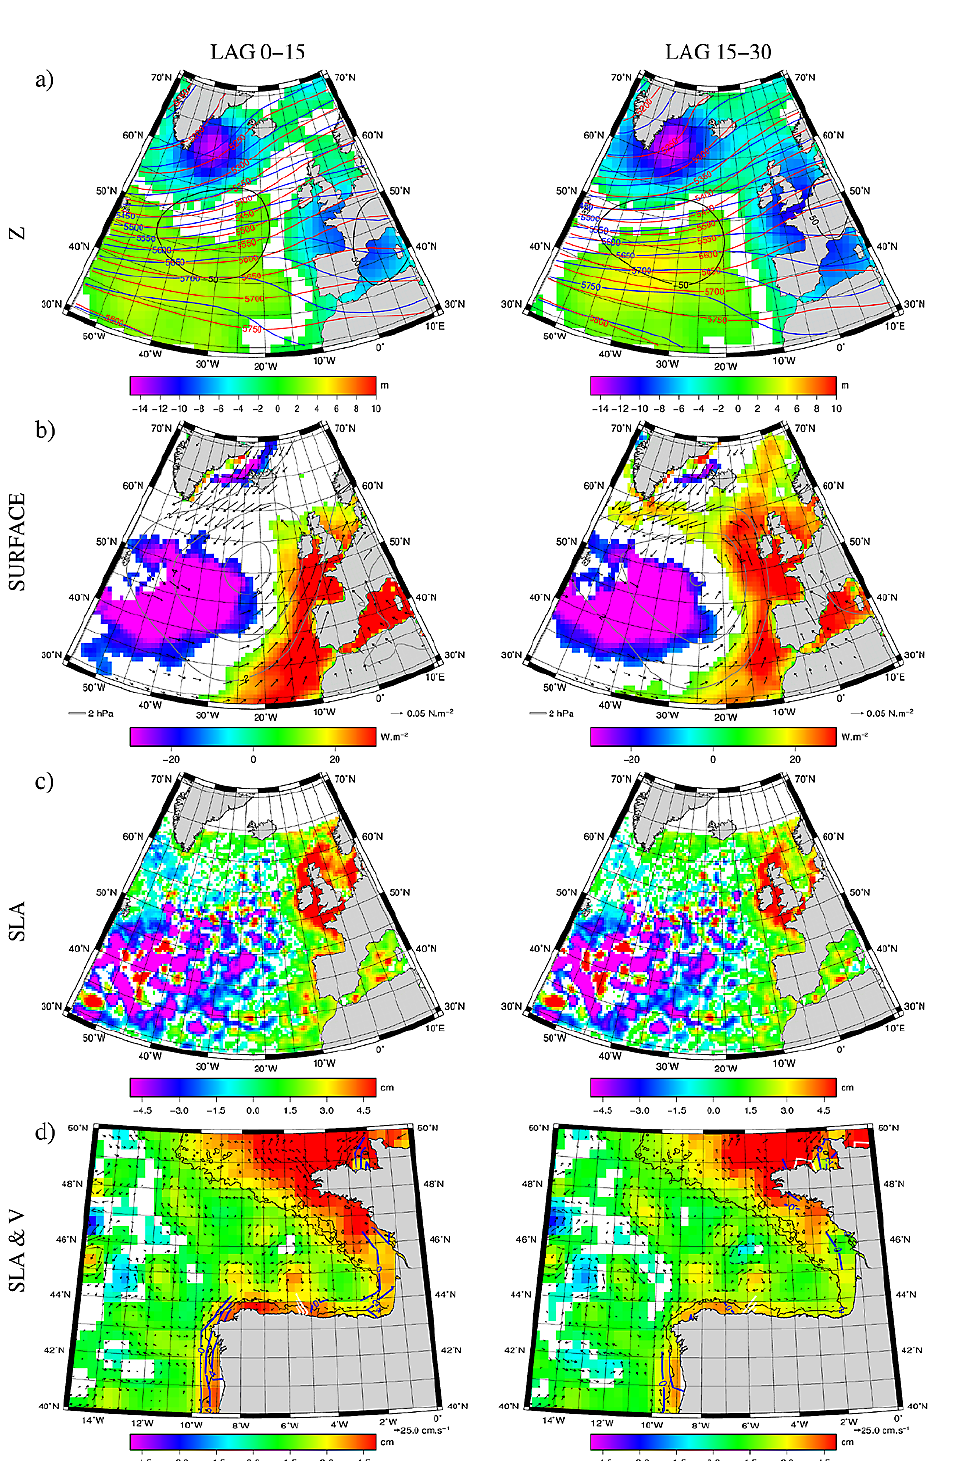
Fig. 10. Composite results based on the IPC-Navidad time series shown in Fig. 7. The analysed variables are the 500hPa geopotential height anomalies ( a ; red, blue and black contours), the estimated location of the storm track ( a ; colour scale), the surface pressure ( b ; grey contours), the surface turbulent fluxes ( b ; colour scale), the wind stress ( b ; arrows), the sea level anomalies (SLA) ( c ; colour scale) and the related current anomalies ( d ; arrows) and the curl of the wind stress ( d ; blue and white contours). The 200m depth contour is shown in the figures in the bottom panels. Left and right panels correspond to the 0–15 and 15–30day lag ranges. All variables are masked by the 95% confidence mask built by means of a t test on the difference of means. See the text for more